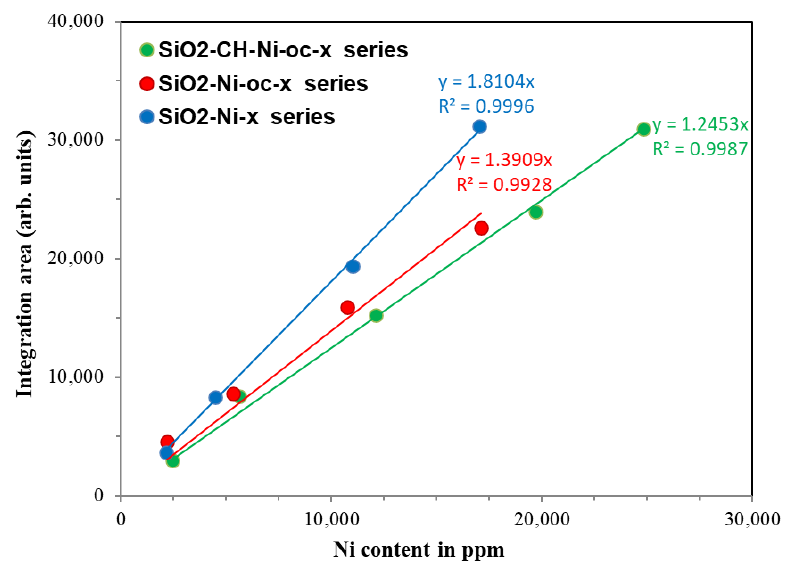
Figure 4. Correlation of the integrated intensity of the (2 0 0) reflection of NiO (bunsenite) versus Ni content of the three series of Ni-loaded SiO 2 samples (linear fit was calculated with zero intercept). As discussed above, the more intense calcination of the Ni/SiO 2 samples at 805 °C for 12 h, being initially calcined at 700 °C for 3 h, had a minor effect on the integrated area of the (2 0 0) reflection. This can be clearly seen from the plots of Figure 5, where the calibra- tion lines of the two sets of samples (mildly and more severely calcined) fall on top of each other.